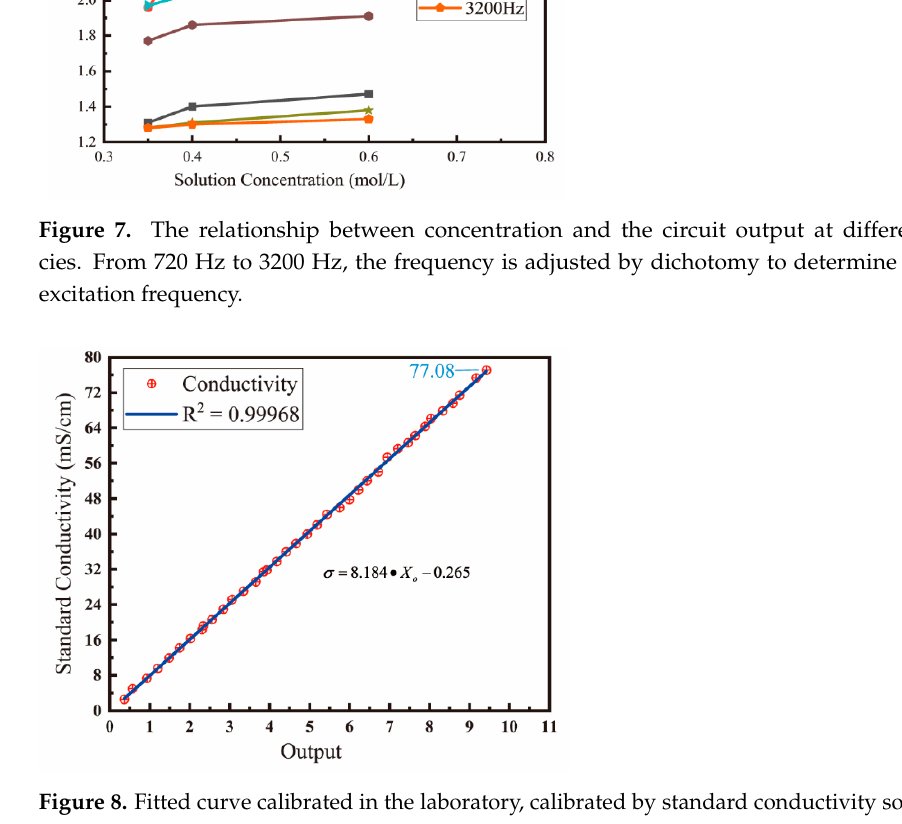
( b ) Figure 9. ( a ) Correspondence between temperature and circuit output. ( b ) Fitting curve calibrated by a third party, which is calibrated by changing the temperature of standard seawater. 4.2. Temperature Calibration